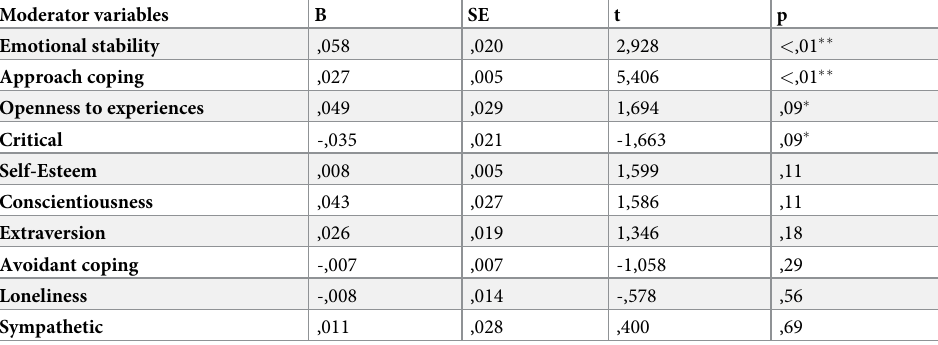
Table 4. Personal resources and characteristics tested for moderation between perceived stress and mental